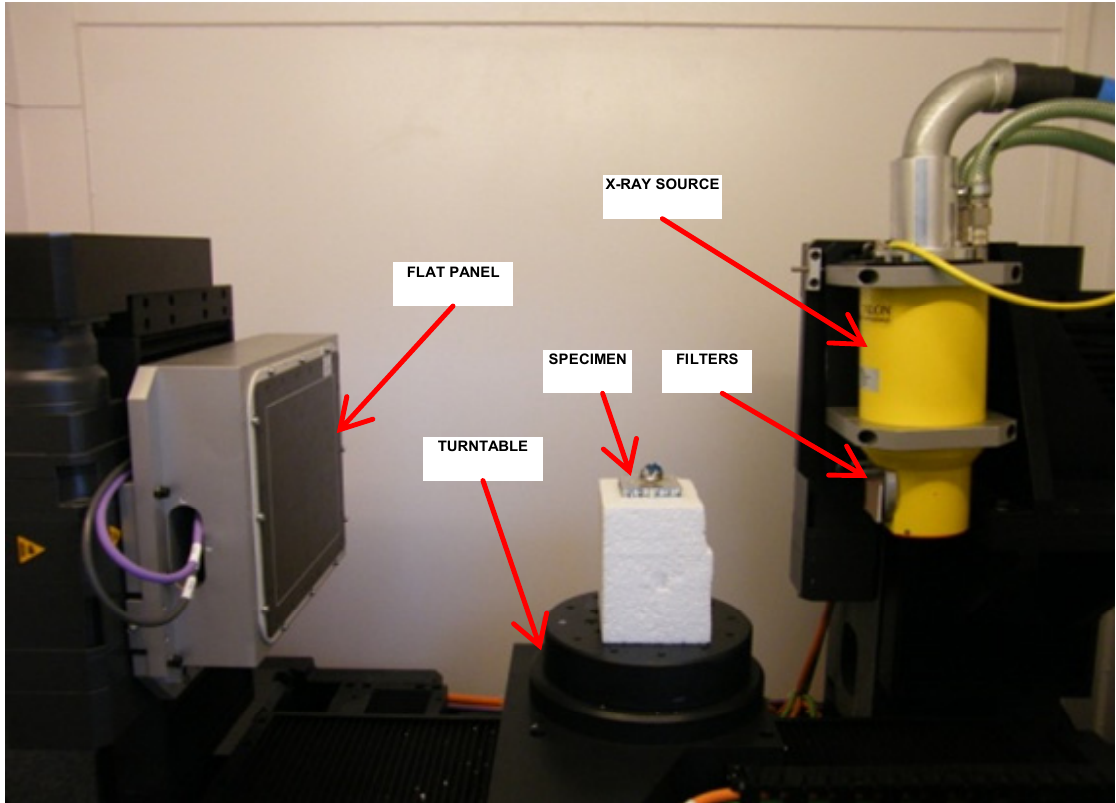
Figure 3. Computed Tomography